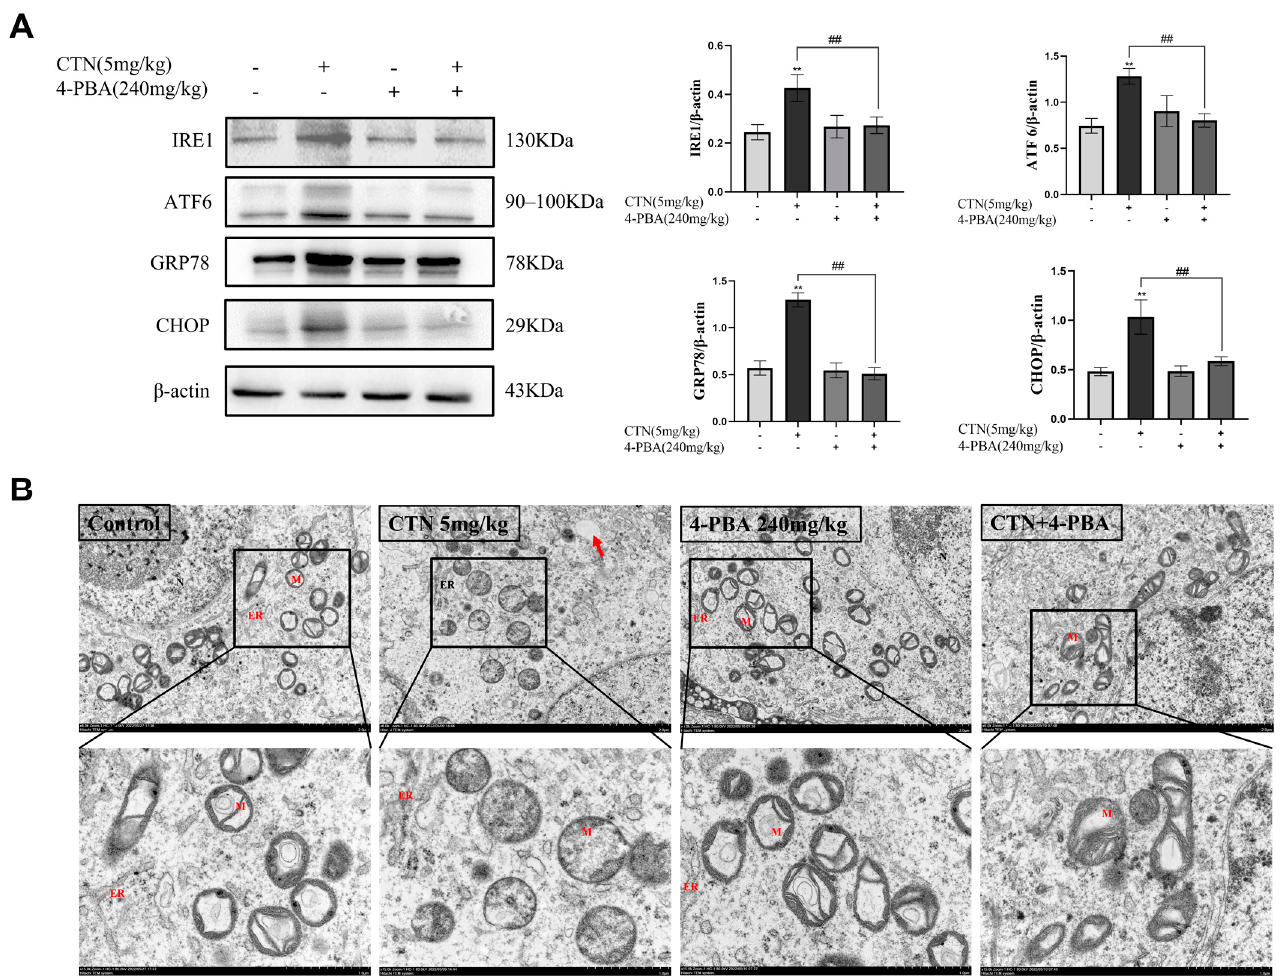
Figure 5. The effects of 4-PBA testicular ERS and ultrastructural changes after CTN exposure. ( A ) IRE1, ATF6, GRP78, CHOP protein expression levels; ( B ) Electron microscopic ultrastructural examination of the testis. (N: nucleus; M mitochondria; → : vacuole-like structures; ER: endoplasmic reticulum). The above data are expressed as SEM ± mean, ** p < 0.01, compared with the control group, ## p < 0.01, compared with the CTN group.